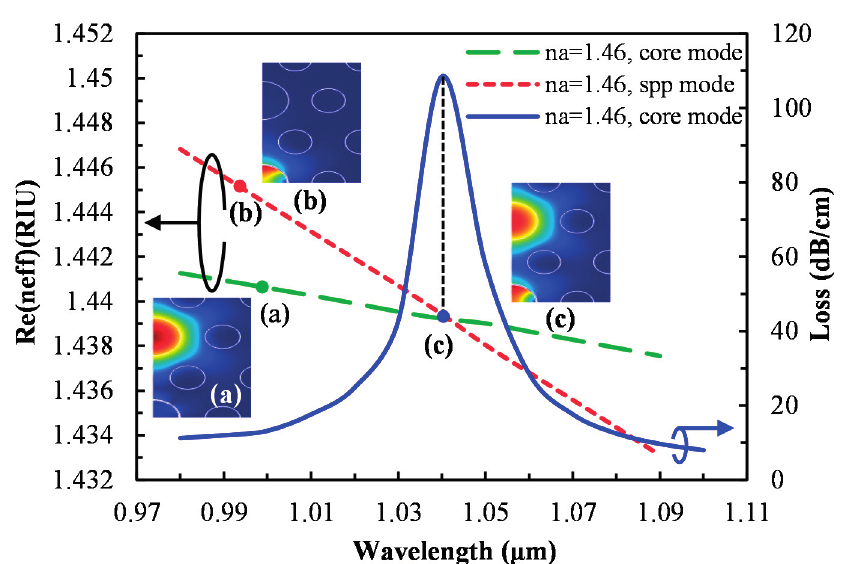
Figure 2. Dispersion relation of the core-guided mode (green), plasmonic mode (red) and the loss spectrum (blue); inset ( a , c ) show the electric field of the core-guided mode and inset ( b ) shows the electric field of the plasmonic mode.